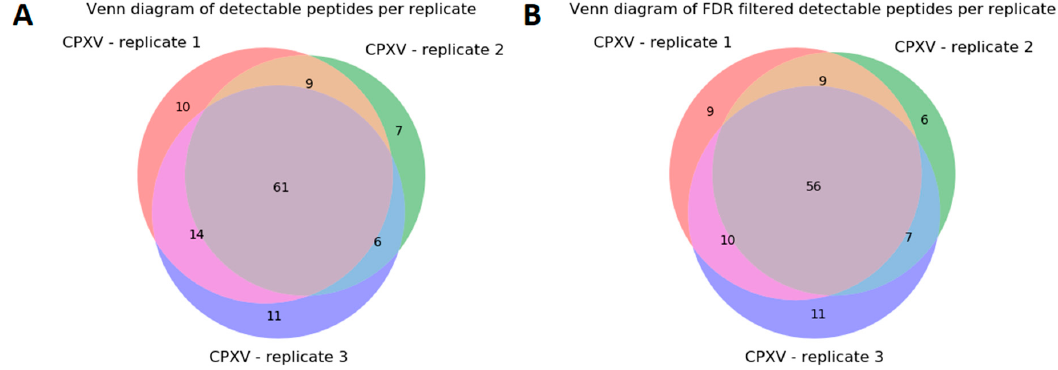
without applying any false discovery rate (FDR) threshold ( A ) and filtered by 1% FDR ( B